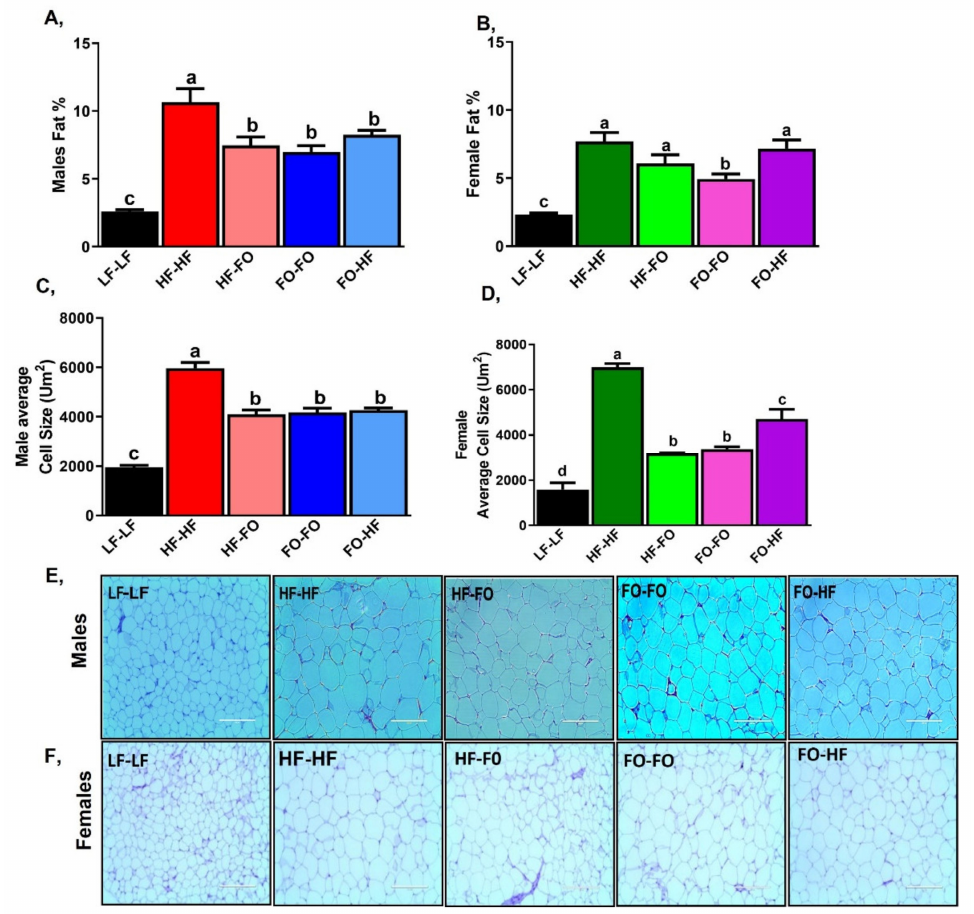
Figure 4. Fish oil supplementation alters overall adiposity in both male and female mice :( A , B ) Body fat composition in male and female mice. ( C – F ) Mean adipocyte cell area in male and female mice along with their representative images (20x magnification and 200 µ m scale). Data is presented as mean ± SEM (n = 4). Common letters on the error bars indicate no significance (e.g., “a” is significantly different from “b” and “ab” indicates no significance compared to “a” and